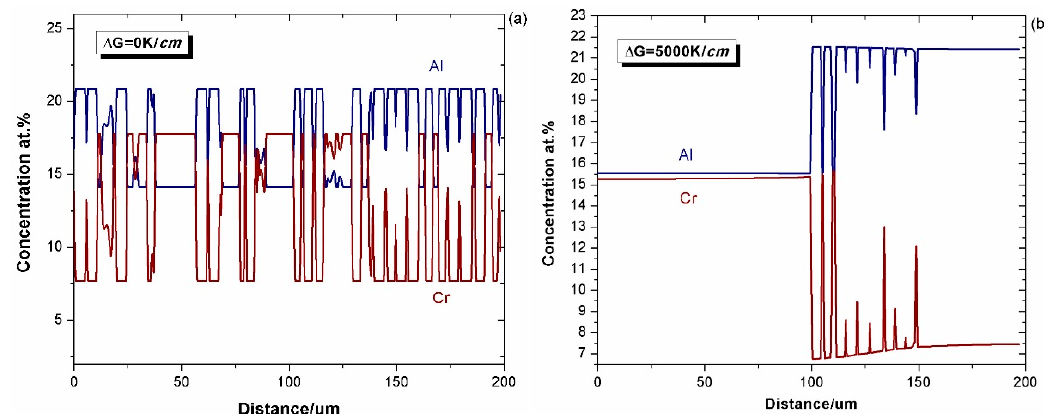
Figure 4. Composition distribution of Al and Cr in No. 5 γ + γ '/ γ + γ ' bond coat/substrate system (Ni–18.5at.%Al–11.25at.%Cr/Ni–18at.%Al–12at.%Cr) annealed ( a ) at 1373 K and ( b ) with an effect of temperature gradient Δ G = 5000 K/cm at 805,000 s.